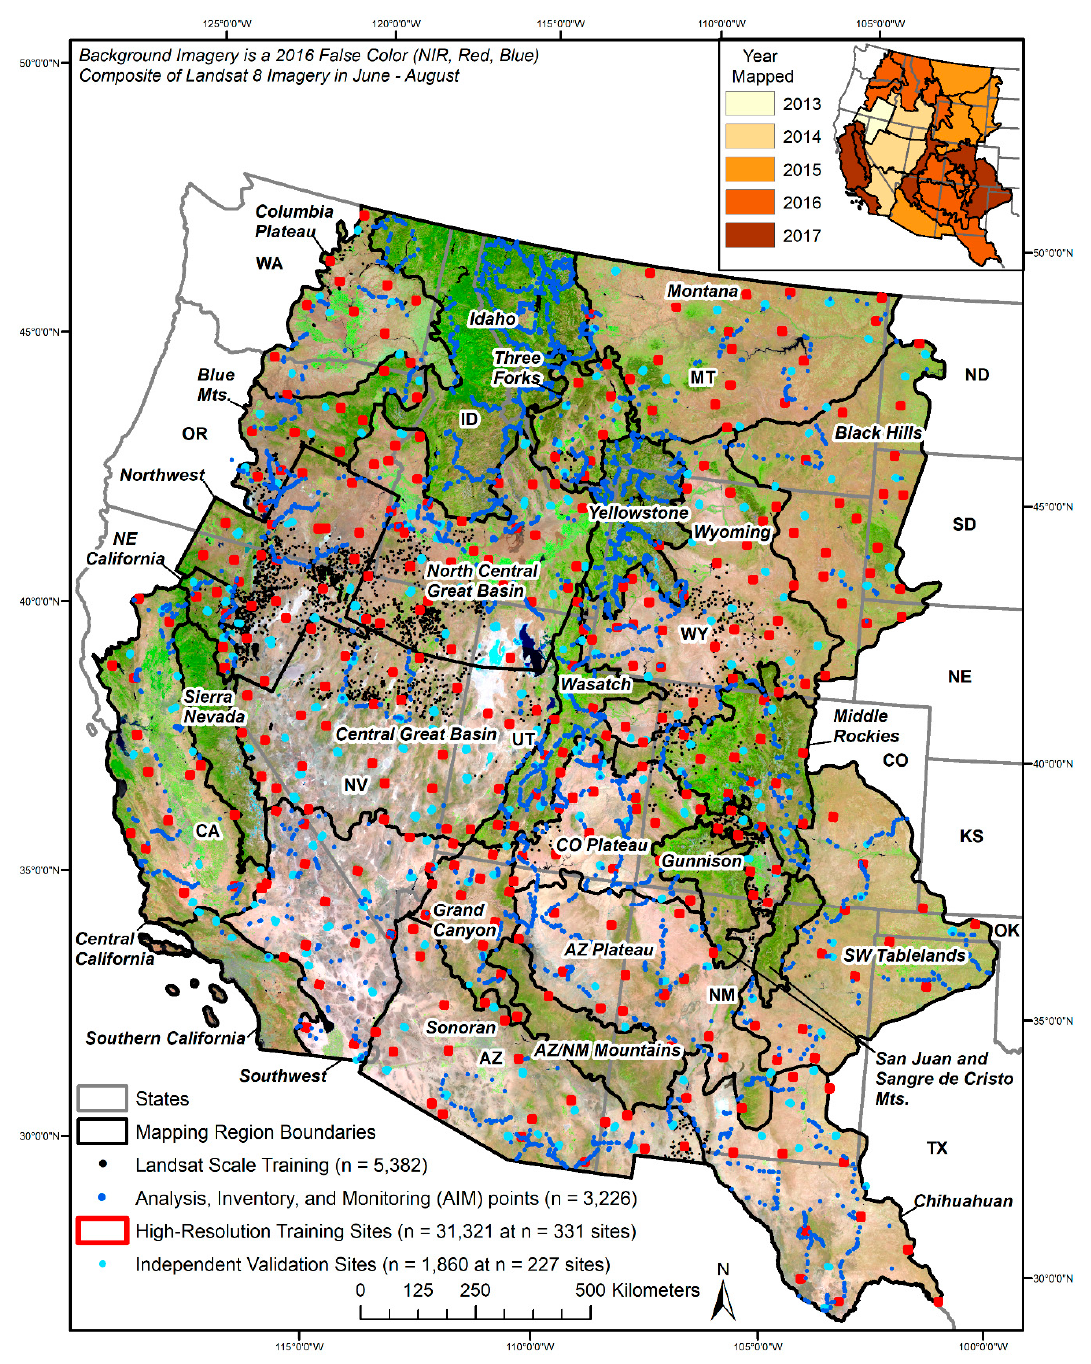
Figure 1. Mapping regions and field data used in model development and assessment of fractional cover components in the western U.S. Mapping region names are indicated by italicized text, and state abbreviations annotated. Inset map shows the nominal year in which field observations and Landsat imagery were obtained for each region.